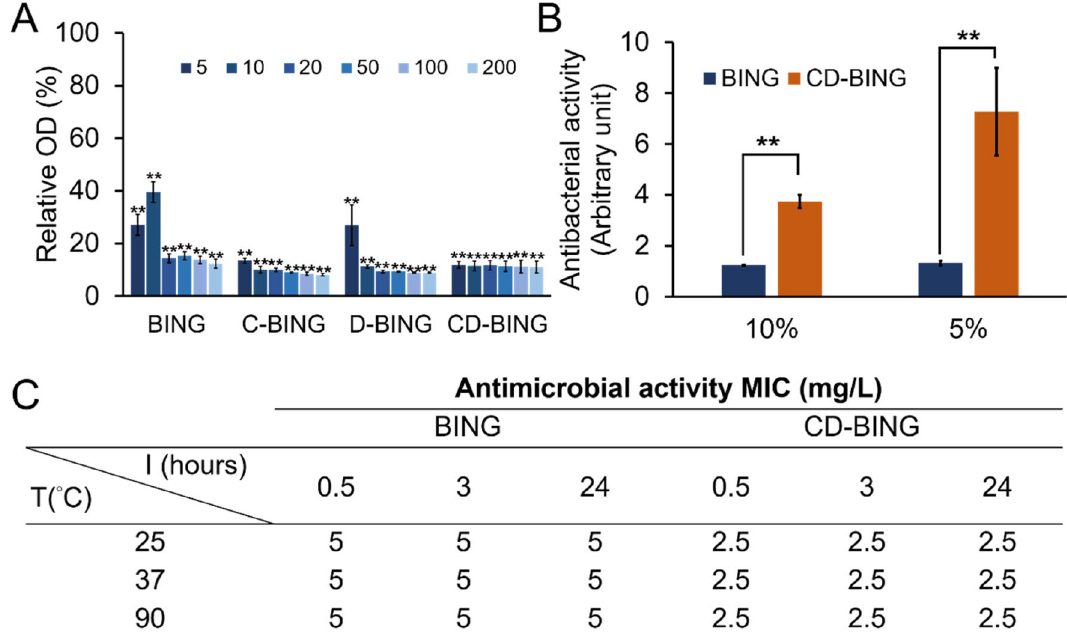
Figure 9. Antibacterial activities of modified BING. ( A ) Relative viability of E. coli treated with BING that is unmodified (BING), C-amidated (C-BING), d-isomer substituted (D-BING) and both C-amidated and d-isomer substituted (CD-BING) for 16 h. Data are expressed as relative cell density compared to the untreated group. Unit of peptide concentration: µg/mL. ( B ) MIC of BING and CD-BING against of E. coli in the presence of 5% and 10% of fetal bovine serum. Data are expressed as the MIC relative to those of BING and CD-BING in the absence of serum. Bars represent means (n = 3) with error bars indicating SD. The statistically significant difference as compared to culture medium controls (* p < 0.05; ** p < 0.01). ( C ) MIC of BING and CD-BING pre- incubated at different temperatures for 0.5, 3 and 24 h (n =